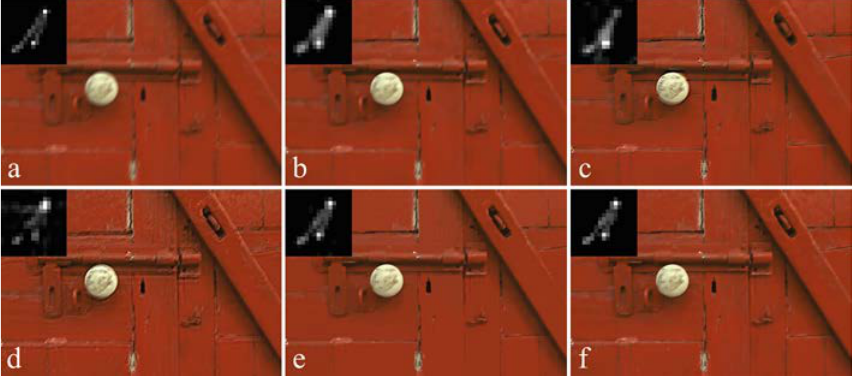
Figure 5. Comparison results for the “RedDoor.png” image: ( a ) blurry image; ( b ) method in [35]; ( c ) method in [36]; ( d ) method in [37]; ( e ) method in [38]; ( f ) proposed method.